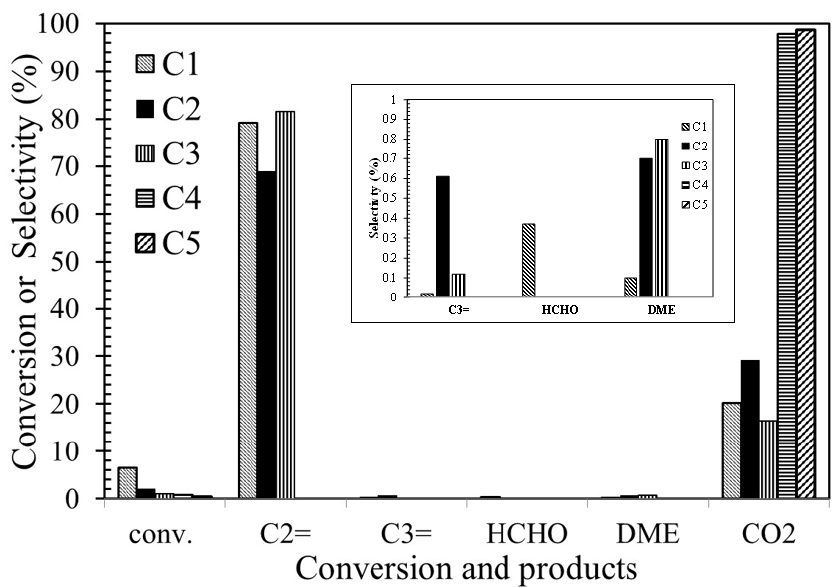
Figure 13. Catalytic performance (conversion (%) and selectivity (%)) of different clays in the study in methanol dehydration. Ethylene (C2=), propylene (C3=), formaldehyde (HCHO), dimethylether (DME) and carbon dioxide (CO 2 ).